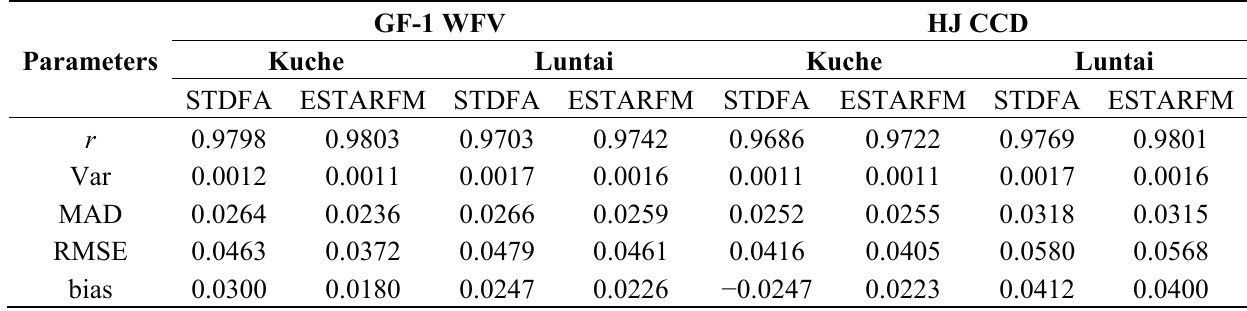
Table 7. Result of the correlation analysis between synthetic and actual NDVI